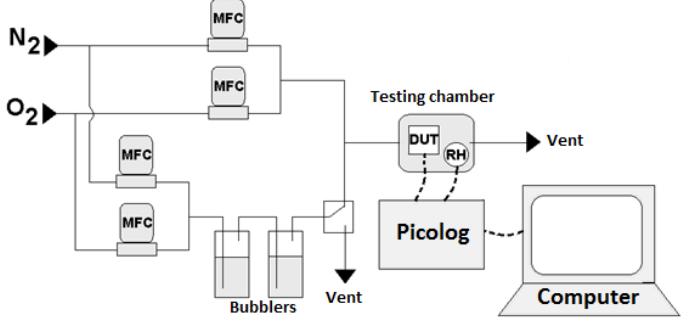
Figure 2. Diagram of the experimental setup employed for O 2 detection